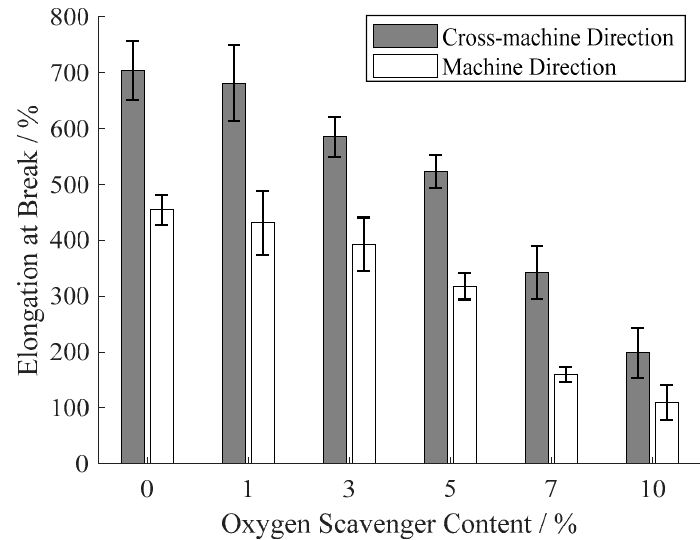
Figure 10. Elongation at break of the prepared films under different oxygen scavenger content.